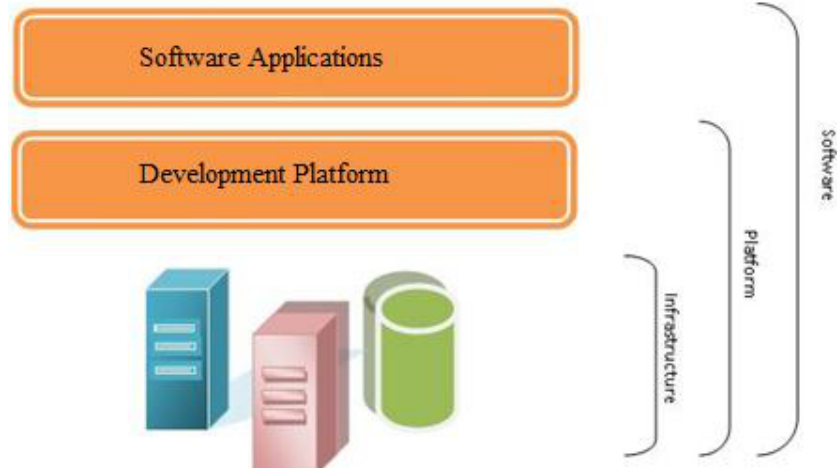
Figure 2. Outline of layers in cloud computing of SaaS, PaaS in addition to